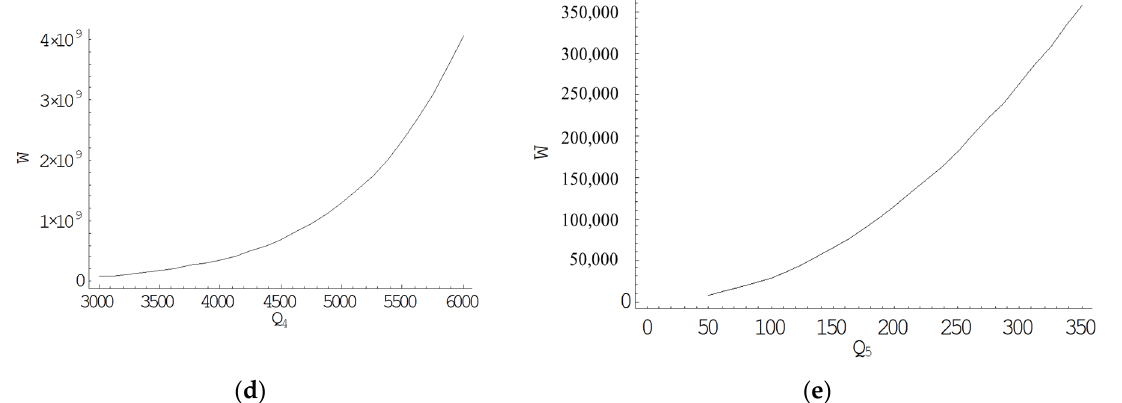
Figure 2. Graphical representation of convexity: ( a ) convexity of the total cost function versus the number of units for cycle 1; ( b ) convexity of the total cost function versus the number of units for cycle 2; ( c ) convexity of the total cost function versus the number of units for cycle 3; ( d ) convexity of the total cost function versus the number of units for cycle 4; ( e ) convexity of the total cost function versus the number of units for cycle 5.